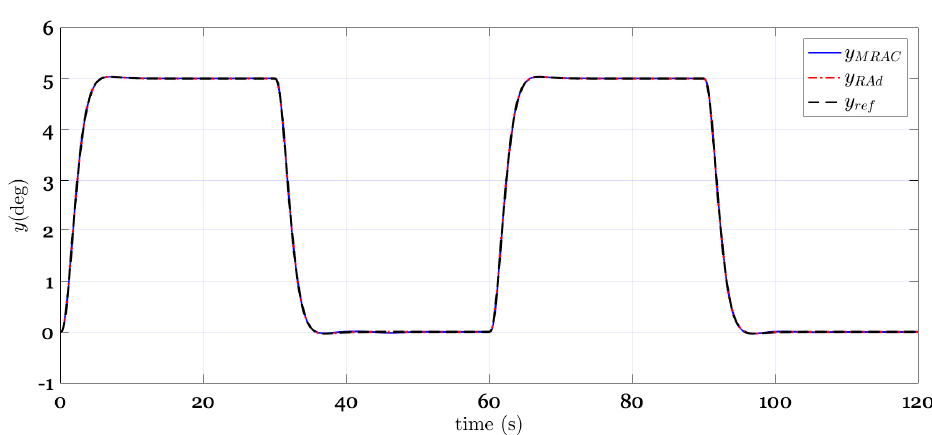
Appl. Sci. 2020 , 10 , x FOR PEER REVIEW Figure 8. Control signal from MRAC and robust adaptive controller with 1 λ θ ρ ρ= = . Figure 8. Control signal from MRAC and robust adaptive controller with ρ λ = ρ θ = 1.